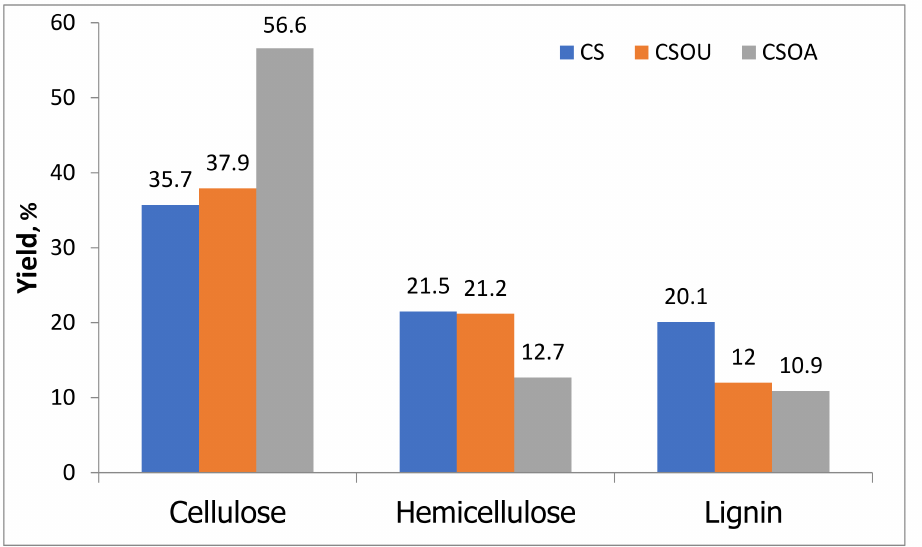
Figure 1. Lignocellulosic composition of CS, CSOA, and CSOU. The values are based on the total weight of untreated CS. Pretreatment condition: autoclave 120 ◦ C, 2% oxalic acid, 1 h, and ultrasonic 60 ◦ C, 2% oxalic acid, 1